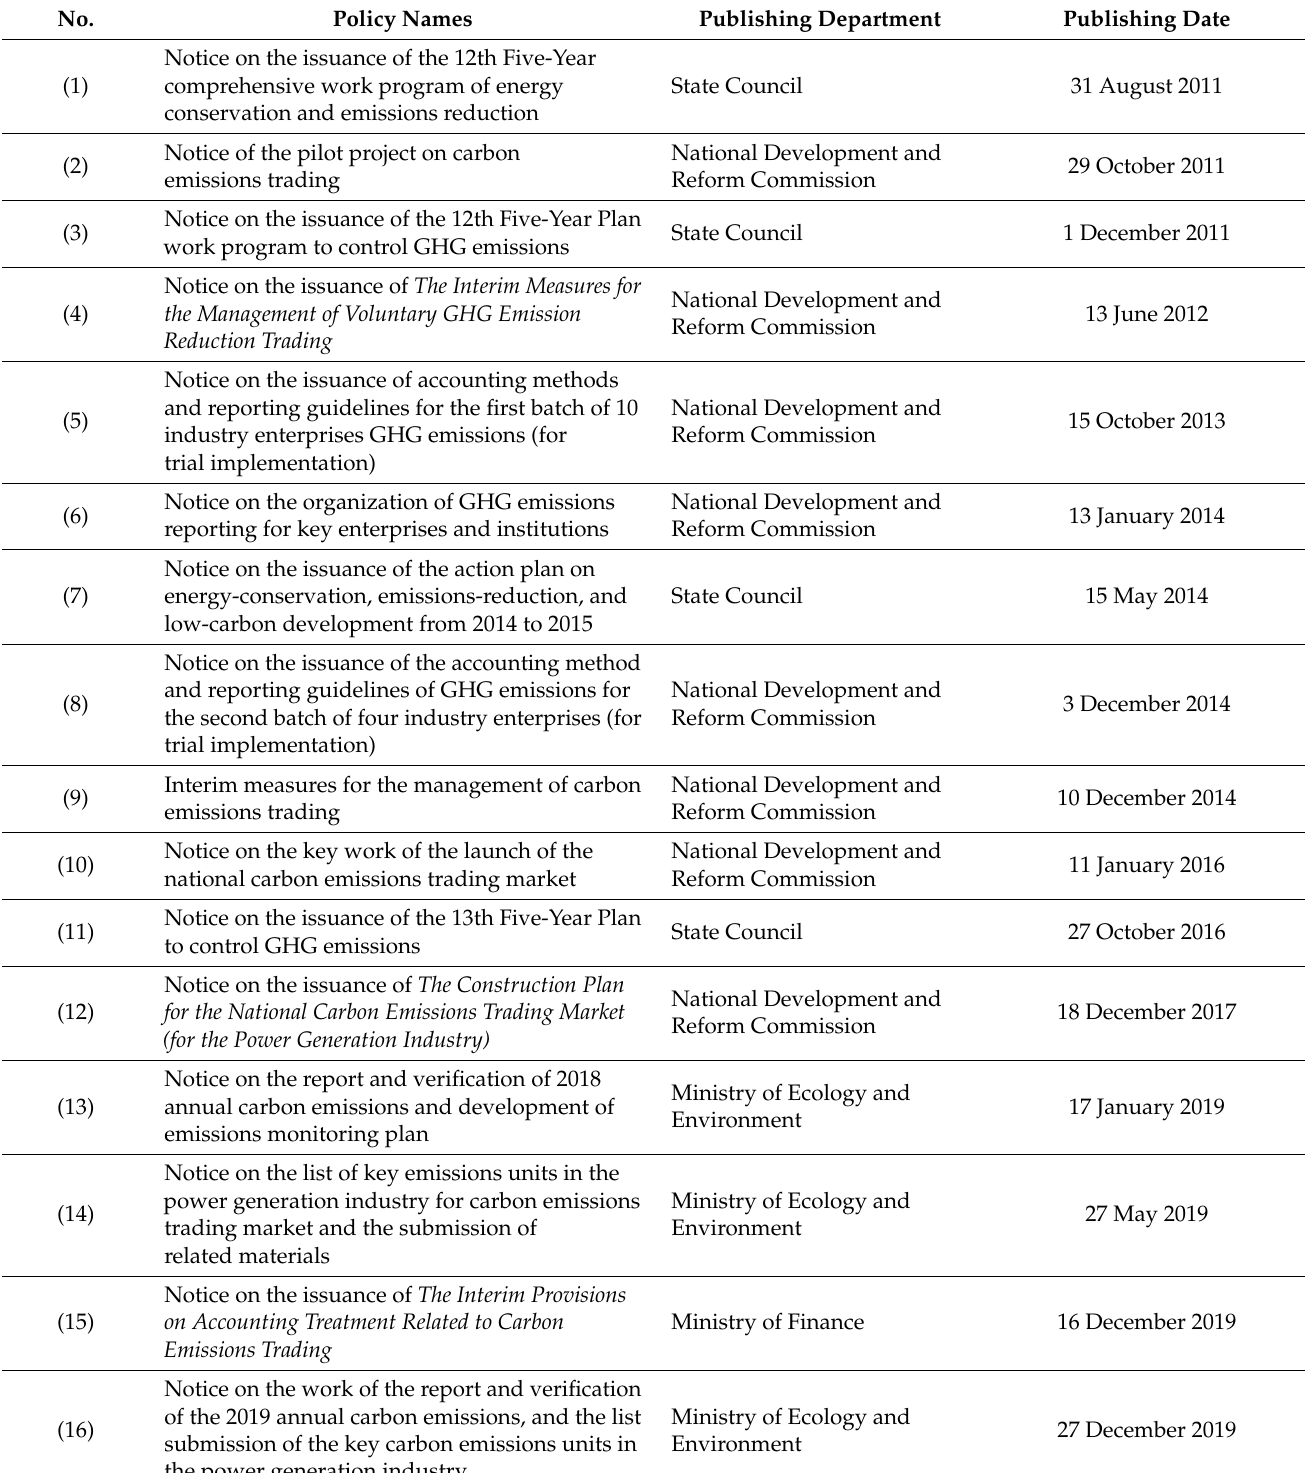
Table A1. Summary of carbon emissions trading policy at the central government